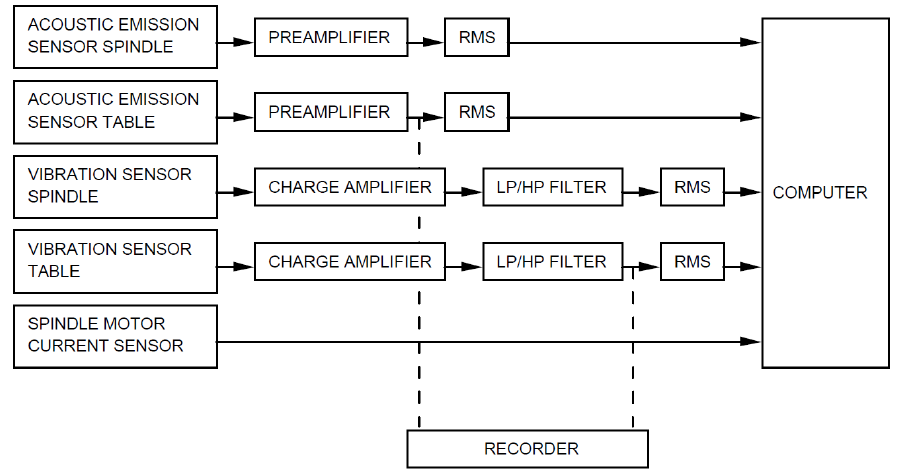
Figure 2. Experimental setup.